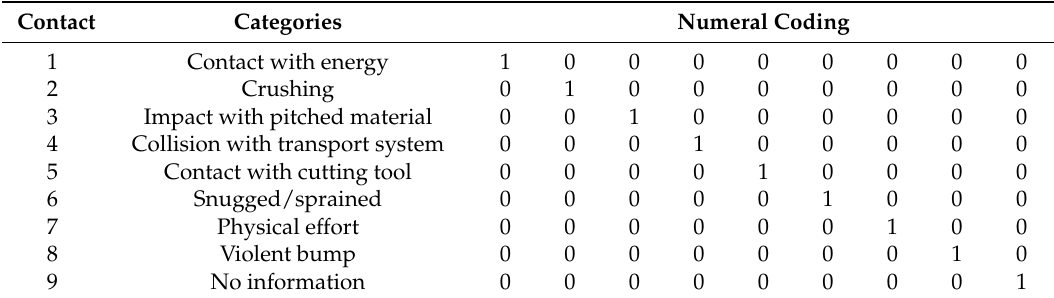
Table 2. Coding table for the ESAW “contact”